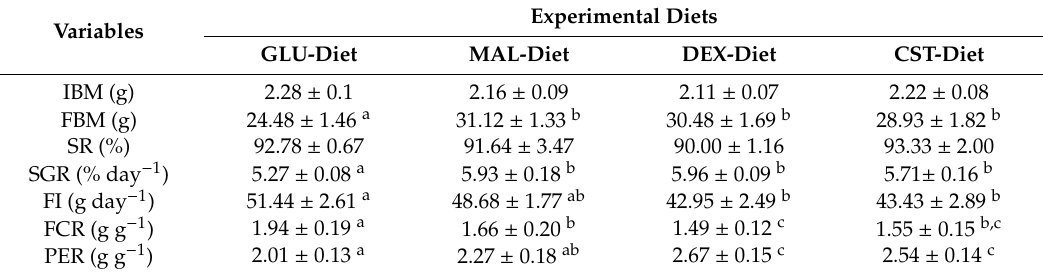
Table 2. Growth performance, feed utilization e ffi ciency and biological parameters of juvenile Nile tilapia fed experimental diets. Each value is a mean ± SEM derived from three replicates, ( n = 3 tanks per diet) a